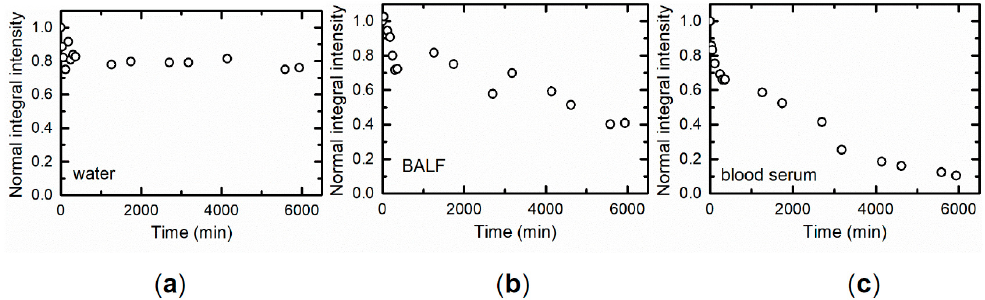
Figure 4. Decay kinetics of the Ni 2+ EPR signal from a filter on which NiO-NPs deposited from the inhalation exposure chamber exhaust air ( a ) in de-ionized water, ( b ) in rat BALF supernatant, and ( c ) in sterile bovine blood serum.